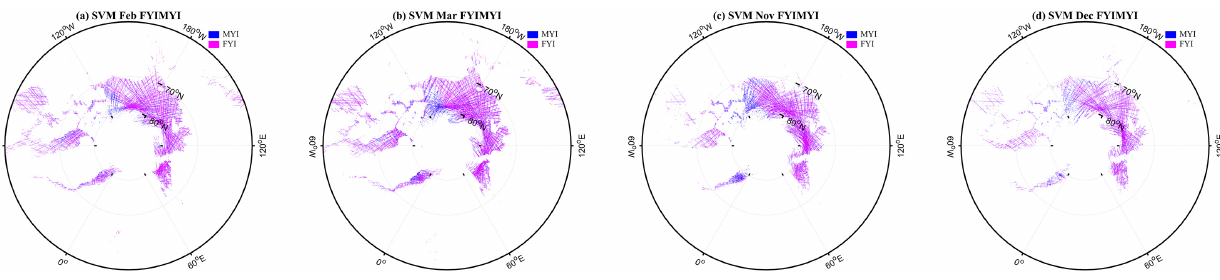
Figure A18. SVM for FYI-MYI classification using the data in April as the training set. The data in ( a ) February, ( b ) March, ( c ) November, and ( d ) December are used as the test set in turn.